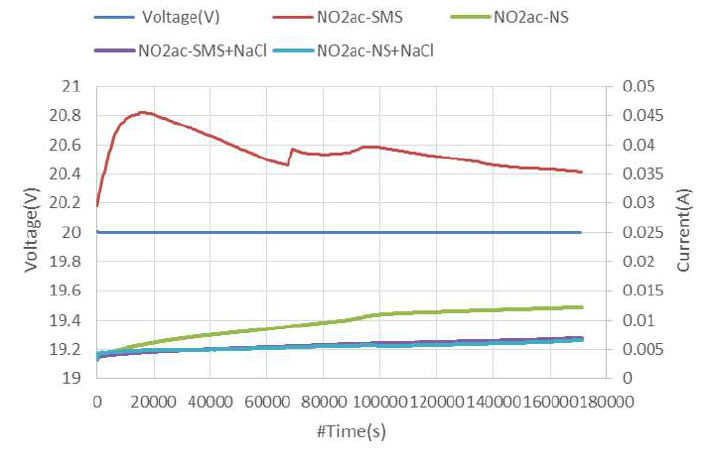
Figure 3. The course of the electrical current in the electrolyte during the preparation of the samples.